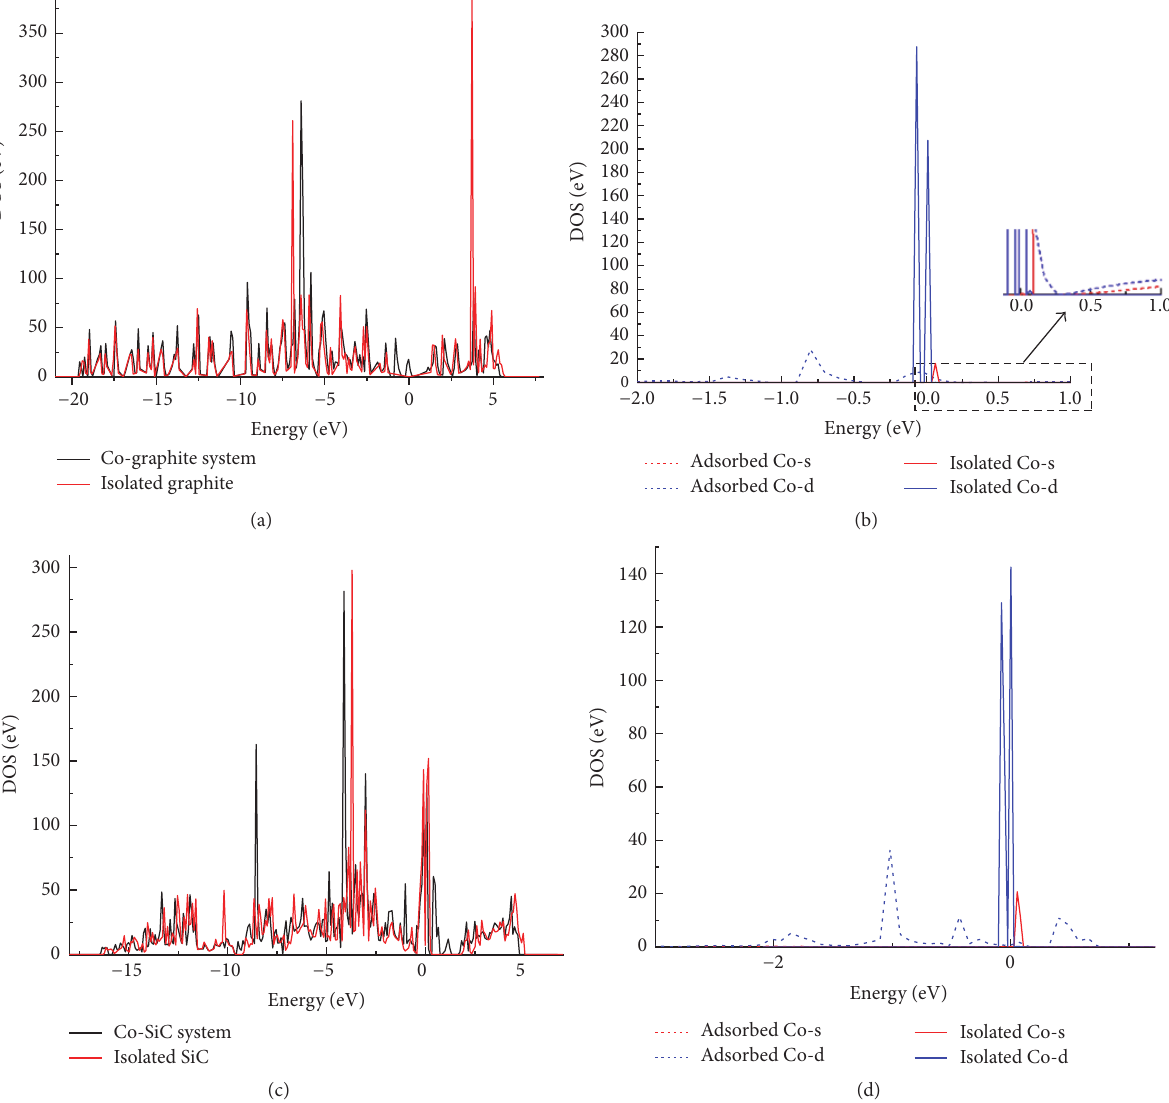
Figure 5: A comparison of DOS with Co: (a) the Co-graphite system and the isolated graphite substrate, (b) the isolated Co atom and the adsorbed Co adatom on the graphite, (c) the Co-SiC system and the isolated SiC substrate, and (d) the isolated Co atom and the adsorbed Co adatom on the SiC. (The number on the abscissa axes indicates the energy difference between the electronic state and the Fermi